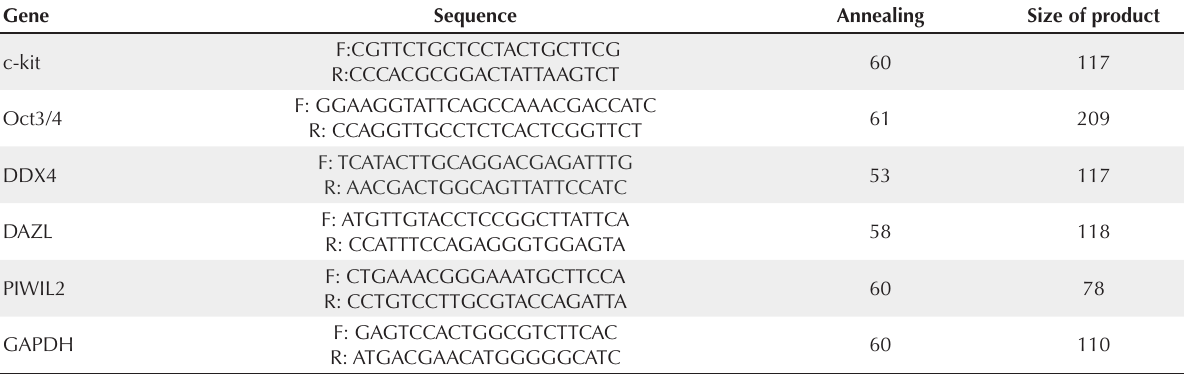
Table 1. Gene-specific primer sequences Gene